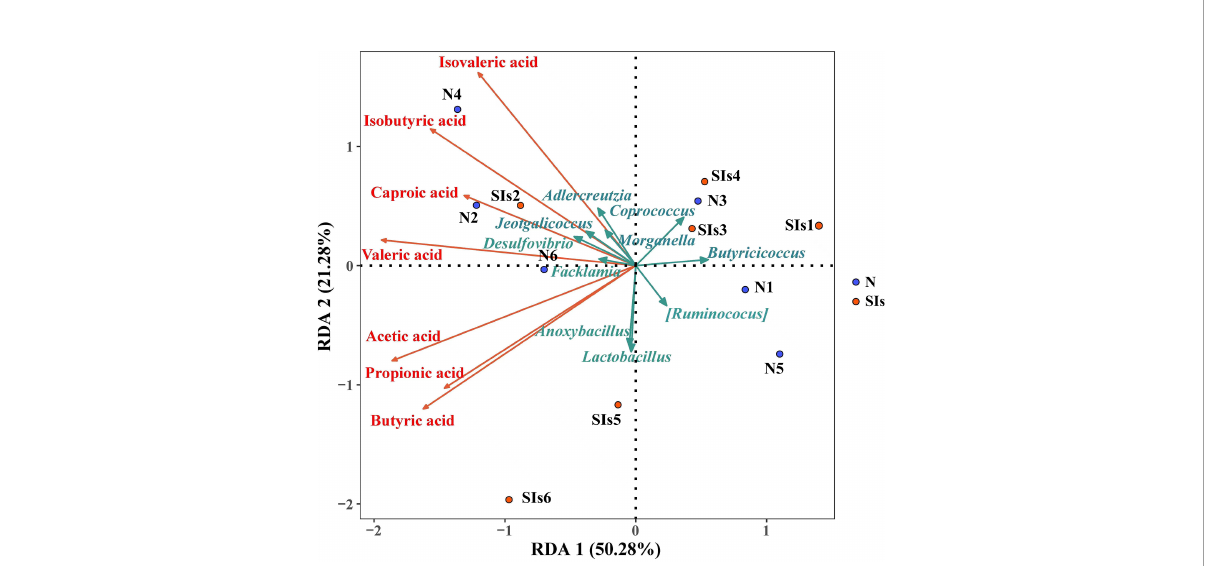
FIGURE 7 Correlation between the differential bacteria and short-chain fatty acids (SCFAs). (Redundancy analysis; n = 6). Colored arrows represent differential bacteria and SCFAs, colored dots represent samples from different groups. Angle between the arrow lines represented correlation; acute angle represents positive correlation and obtuse angle represents negative correlation. N, normal group; SIs, soybean iso fl avones